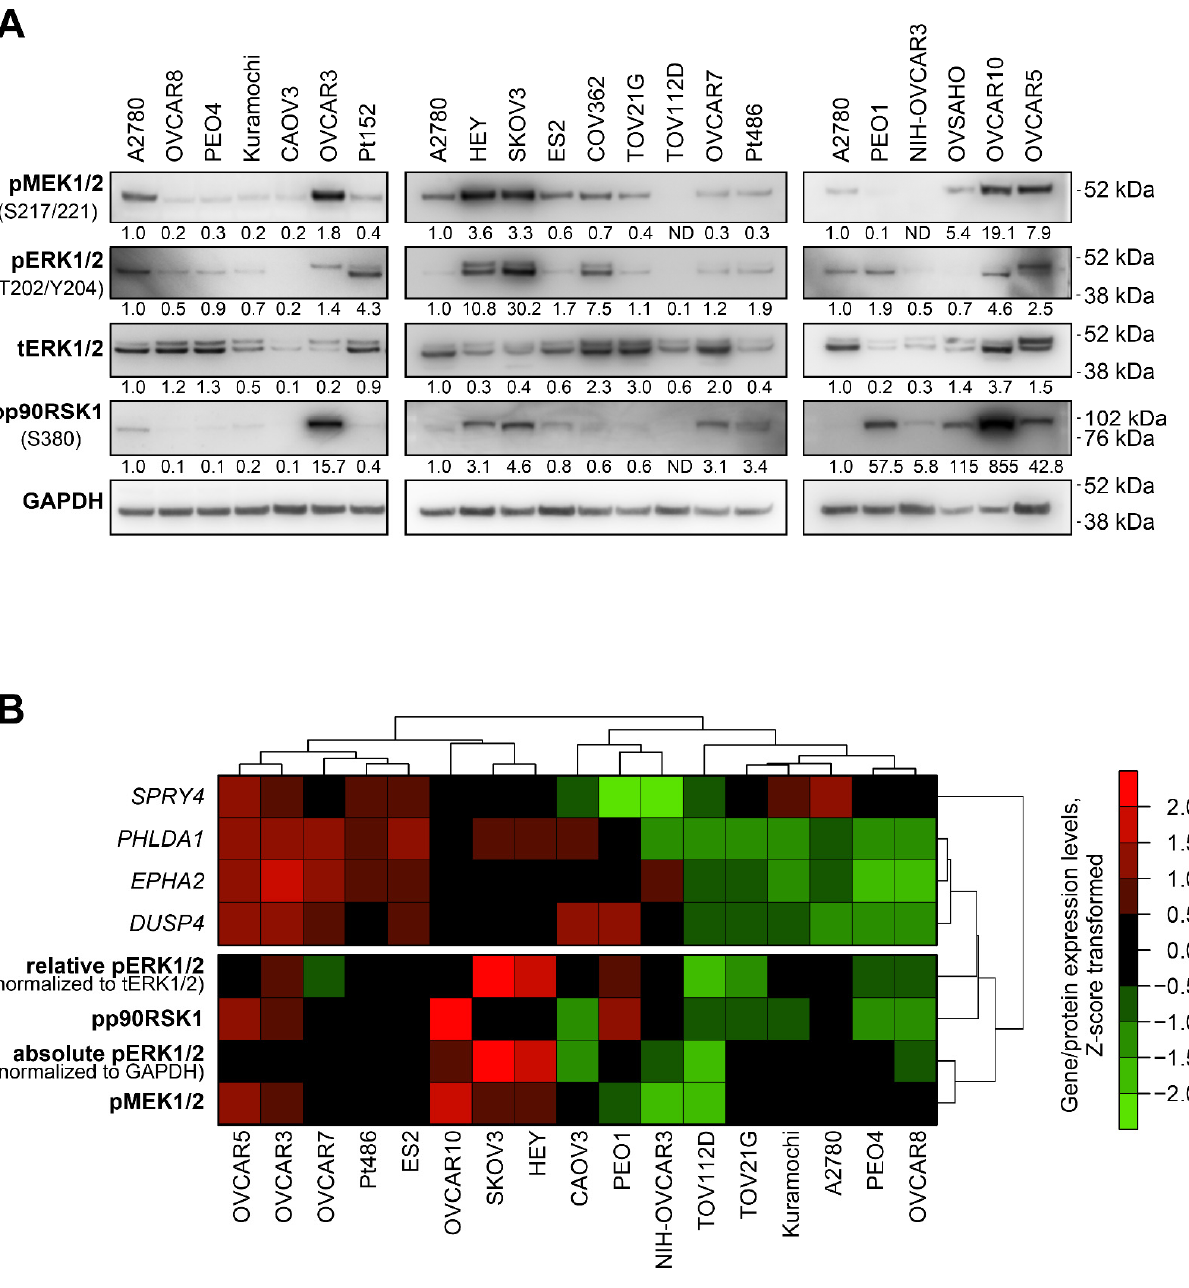
Figure 2. Baseline MEK/ERK pathway activity and PHLDA1, DUSP4, EPHA2, and SPRY4 expression levels in ovarian cancer cell lines. ( A ) Immunoblotting analysis of phosphorylation of MEK/ERK pathway components in 20 human ovarian cancer cell lines. The image represents data obtained from several separate membranes. An A2780 sample was used in each membrane as a reference sample. Numbers under the bands represent relative intensity normalized to GAPDH levels and the A2780 sample. ( B ) Cluster analysis of associations between baseline expression levels of MEK/ERK responder genes and levels of phosphorylated proteins involved in MEK/ERK pathway. Seventeen cell lines displaying consistent activity of several MEK/ERK pathway elements were analyzed. Gene expression levels estimated via RT-qPCR and protein levels estimated via immunoblotting were subjected to Z-score transformation. Unsupervised hierarchical clustering was performed using 1-minus Spearman’s rank correlation metrics.